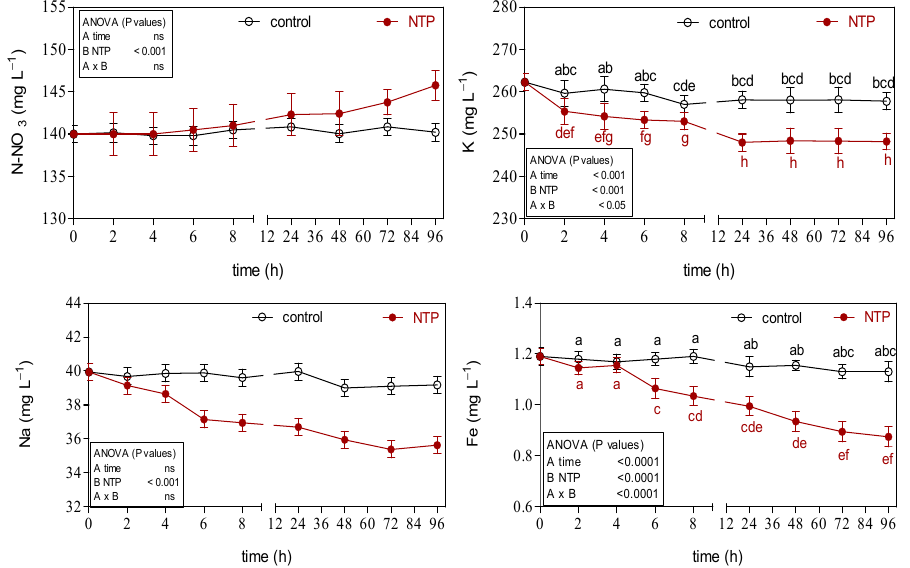
Figure 4. Effect of NTP treatment (120 s every hour) of nutrient solution without plants on concentration of nitrate (N–NO 3 ), potassium (K), sodium (Na), and iron (Fe) (experiment 2). Each value is mean of two replicates (± SE). ANOVA results shown inside graphs. Different letters indicate significant differences between control and NTP treatment according to LDS test at 5% level. Different letters indicate significance at p < 0.05 and 0.01, respectively.